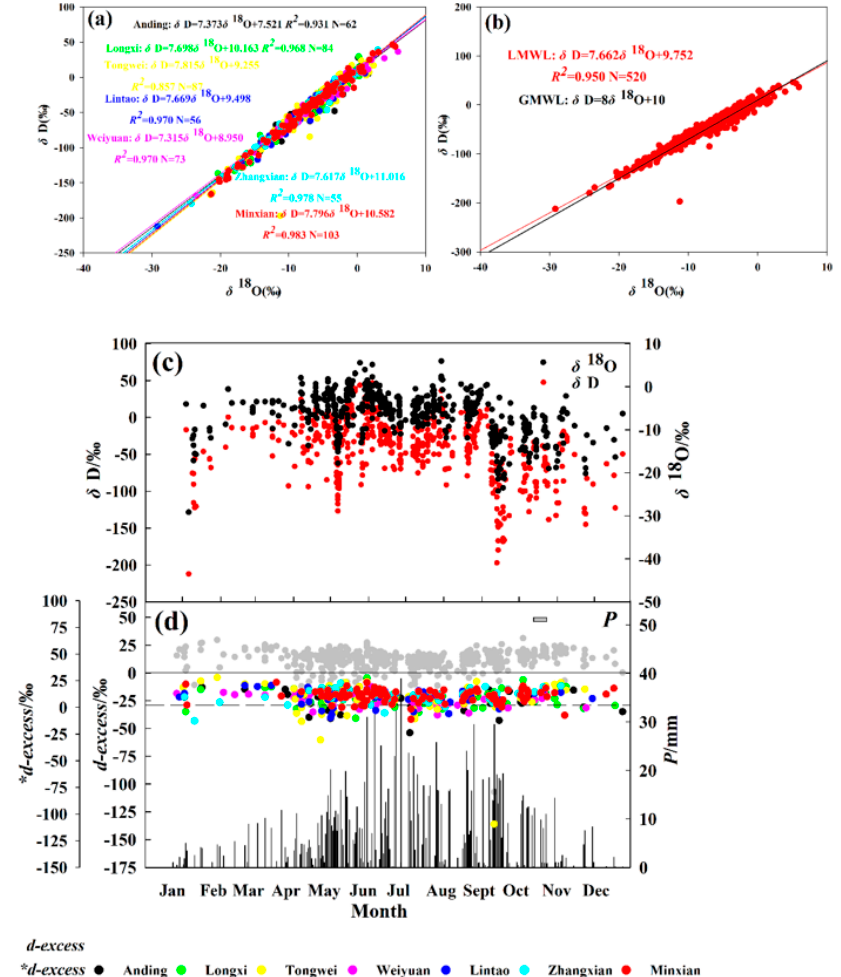
Figure 2. ( a ) linear relationship between δ D and δ 18 O at each sampling station in Dingxi. ( b ) linear relationship between δ D and δ 18 O using all samples collected in Dingxi. ( c , d ) Temporal variations δ 18 O, δ D, d-excess , * d-excess , and local precipitation amount in Dingxi (including all sampling stations)